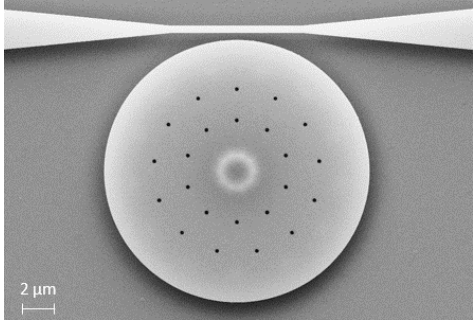
Figure 1. Scanning electron microscope image of a Si optomechanical disk with an 8 µm radius and its tapered waveguide .The black circles are release holes.